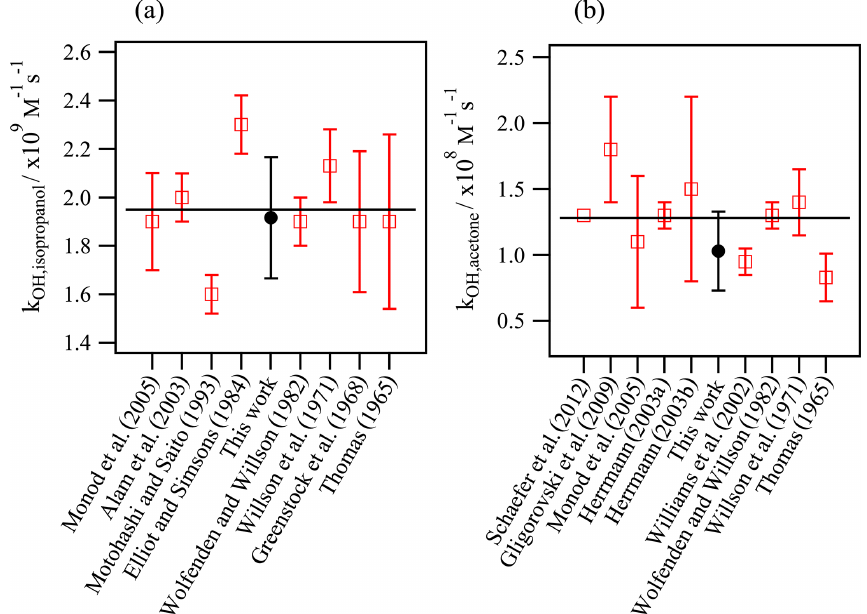
Figure 3. Validation experiments: determination of the aqueous-phase k OH values using the new developed method and comparison with the reported values in the literature for (a) isopropanol and (b) acetone. The horizontal line represents the average value of the previous studies. (cid:113) propyl nitrate, a secondary organic nitrate, the OH attack is reduced by an order of magnitude compared to n